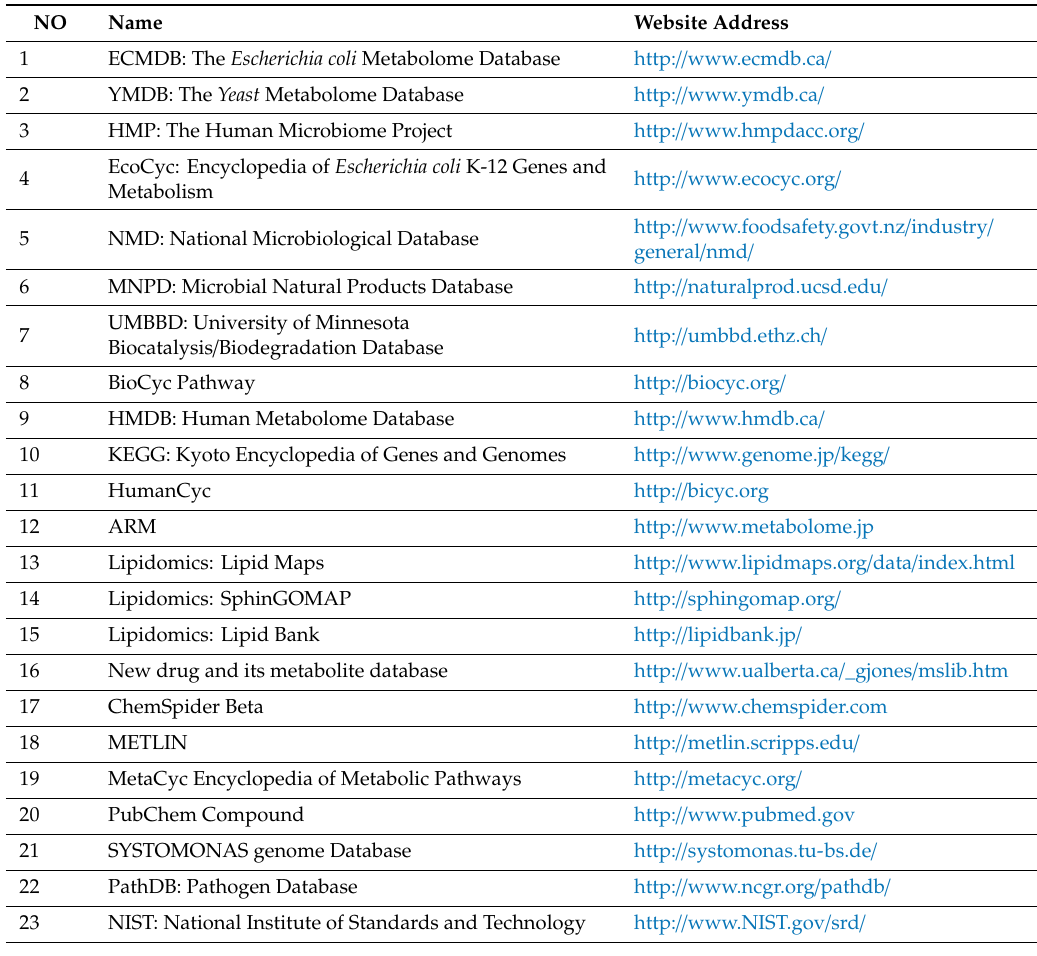
Table 1. Databases for